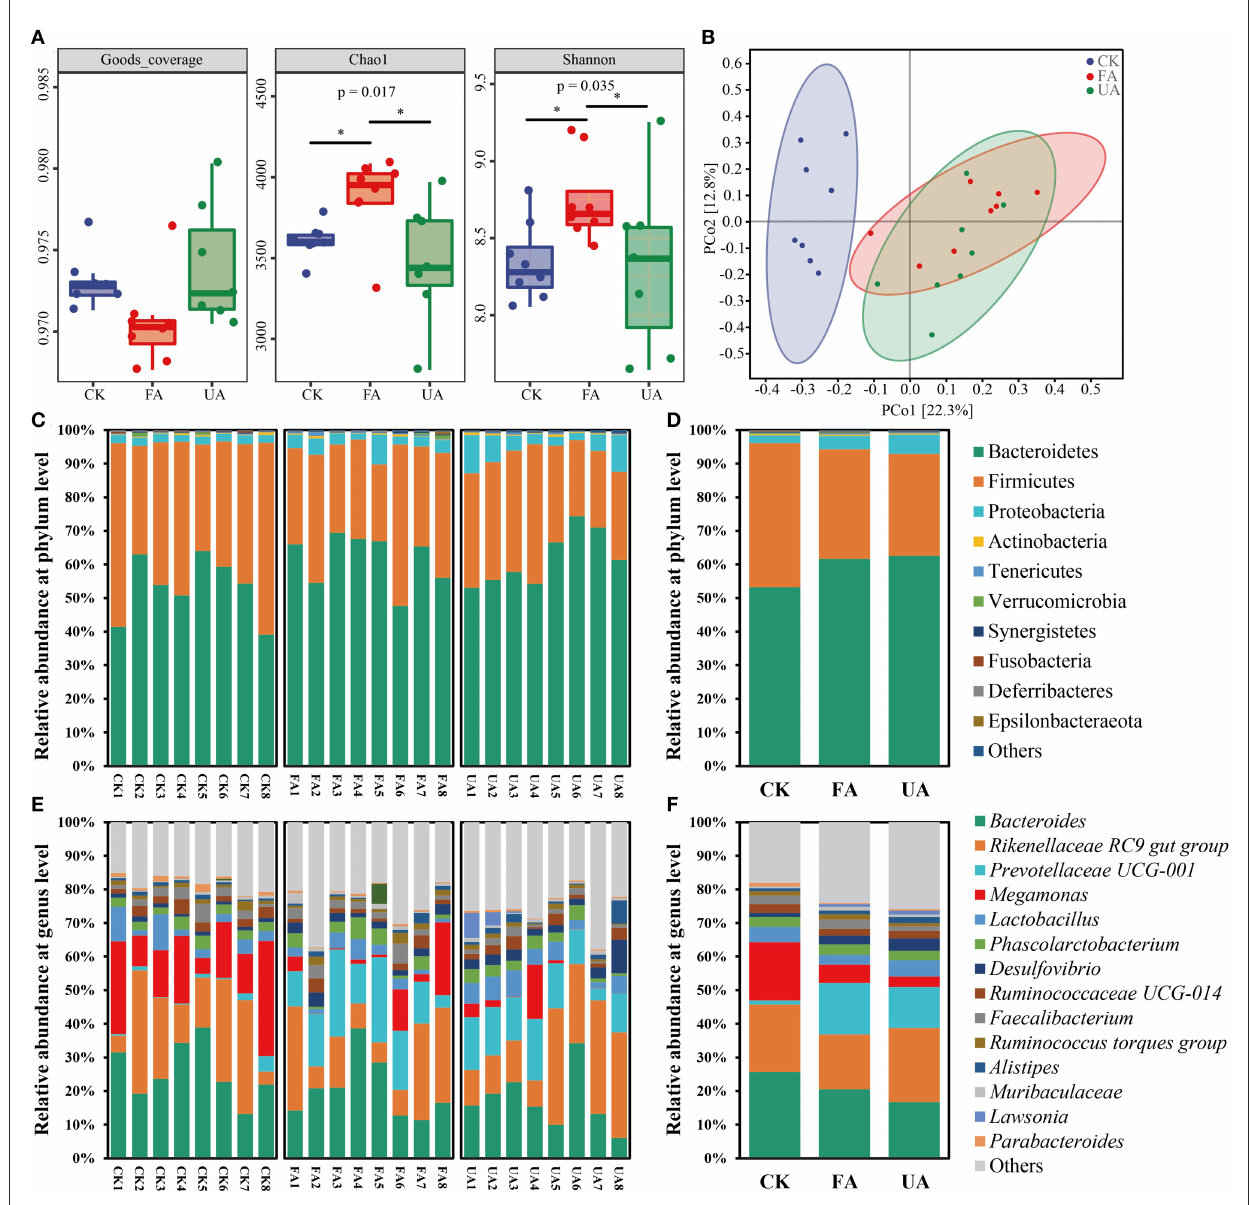
FIGURE6 Intestinal microbiota of laying hens after feeding experiments, including α -diversity (A) , β -diversity (B) , bacterial composition at the phylum level (C) , bacterial composition at the phylum level on average (D) , bacterial composition at the genus level (E) , and bacterial composition at genus level on average (F) . Here, the Bray–Curtis distance was used with an authority of 0.95 to calculate the β